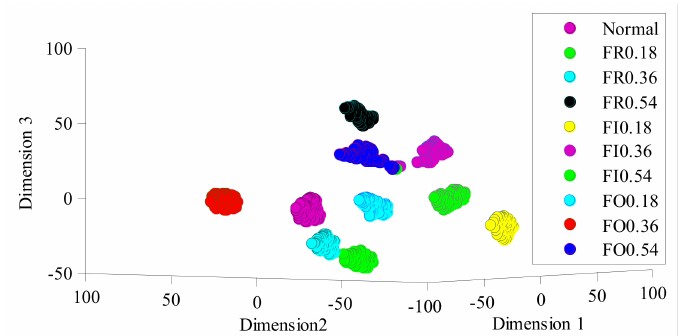
Figure 6. Visualization maps of the learned features of DA task B →